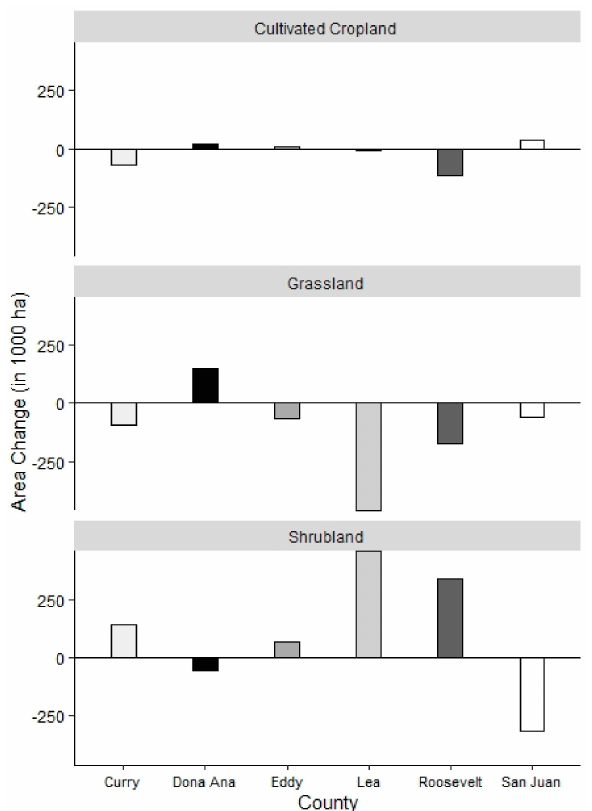
Figure 8. Area change of cultivated cropland,grassland, and shrubland from 1992 to